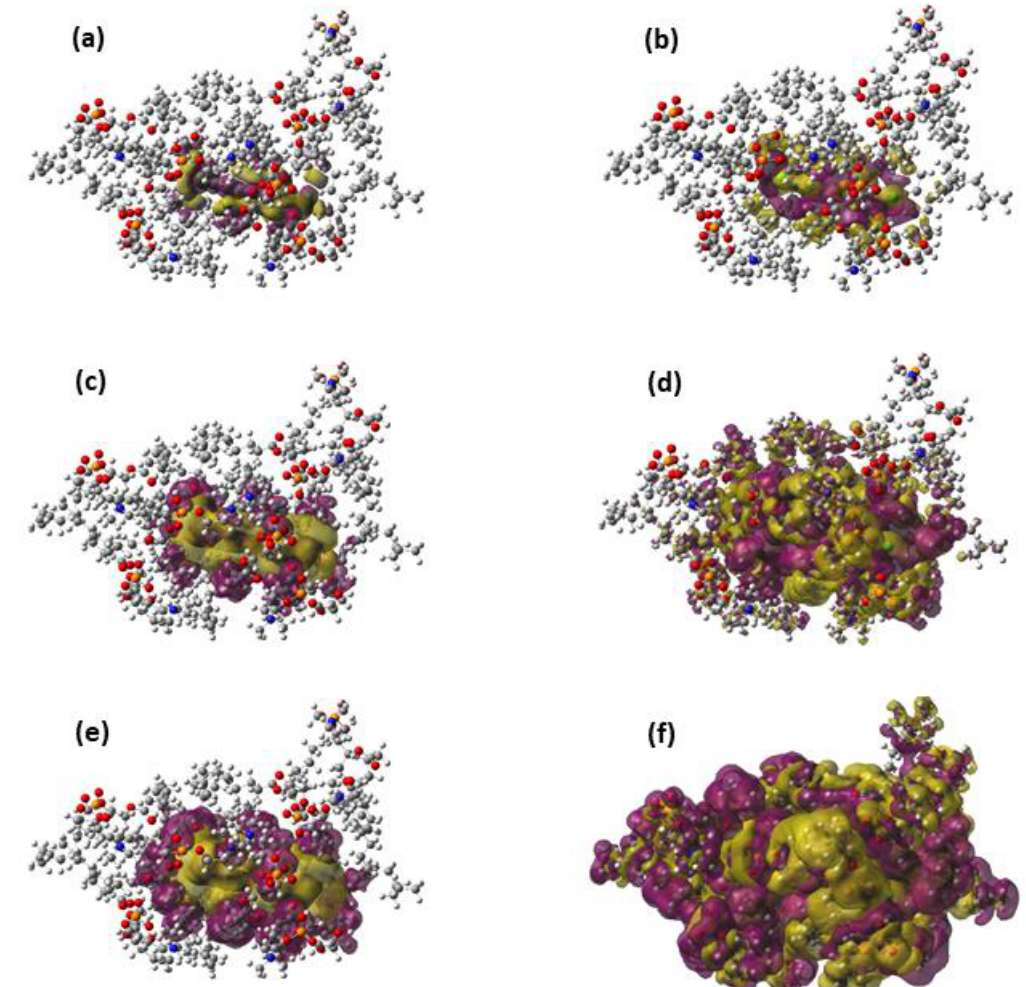
Figure 3. Representations of the Pauli deformation density ( a , c and e ) and the polarization density ( b , d and f ) for an arbitrary geometry around the free energy minimum of the TCDD permeation. The representation includes only the TCDD molecule and the seven DOPC molecules included in the QM region. The following density cut-offs have been used: 10 −4 ( a and b ), 10 −5 ( c and d ) and 10 −6 ( e and f ).